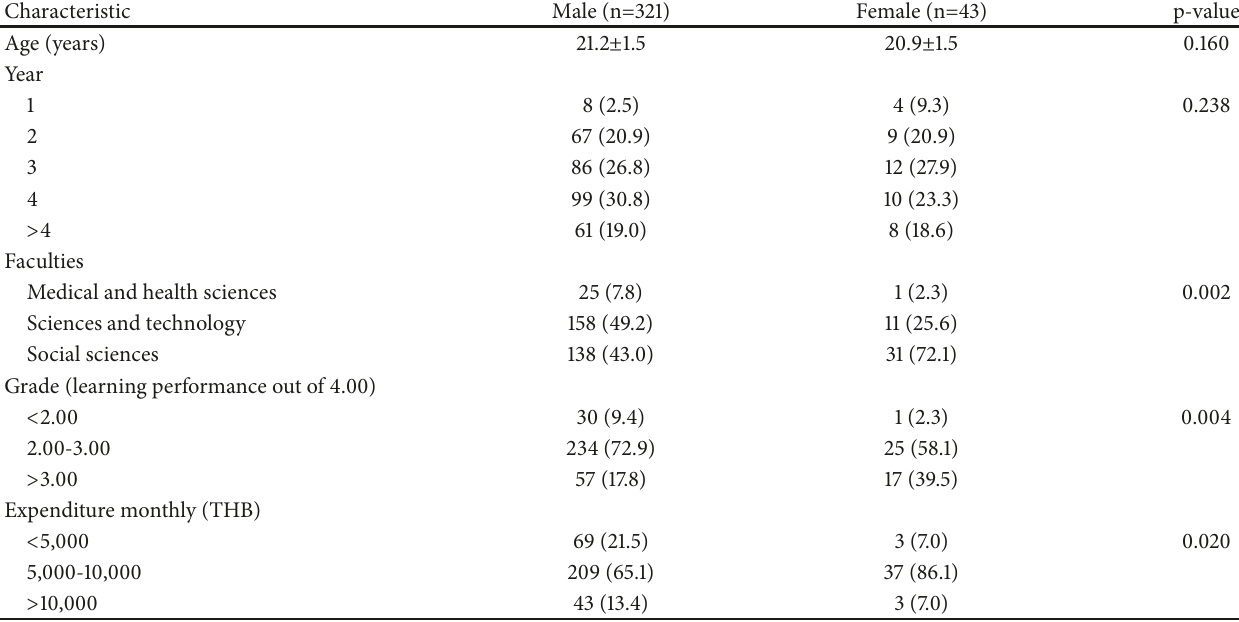
Table 1: Participants’ characteristics by sex